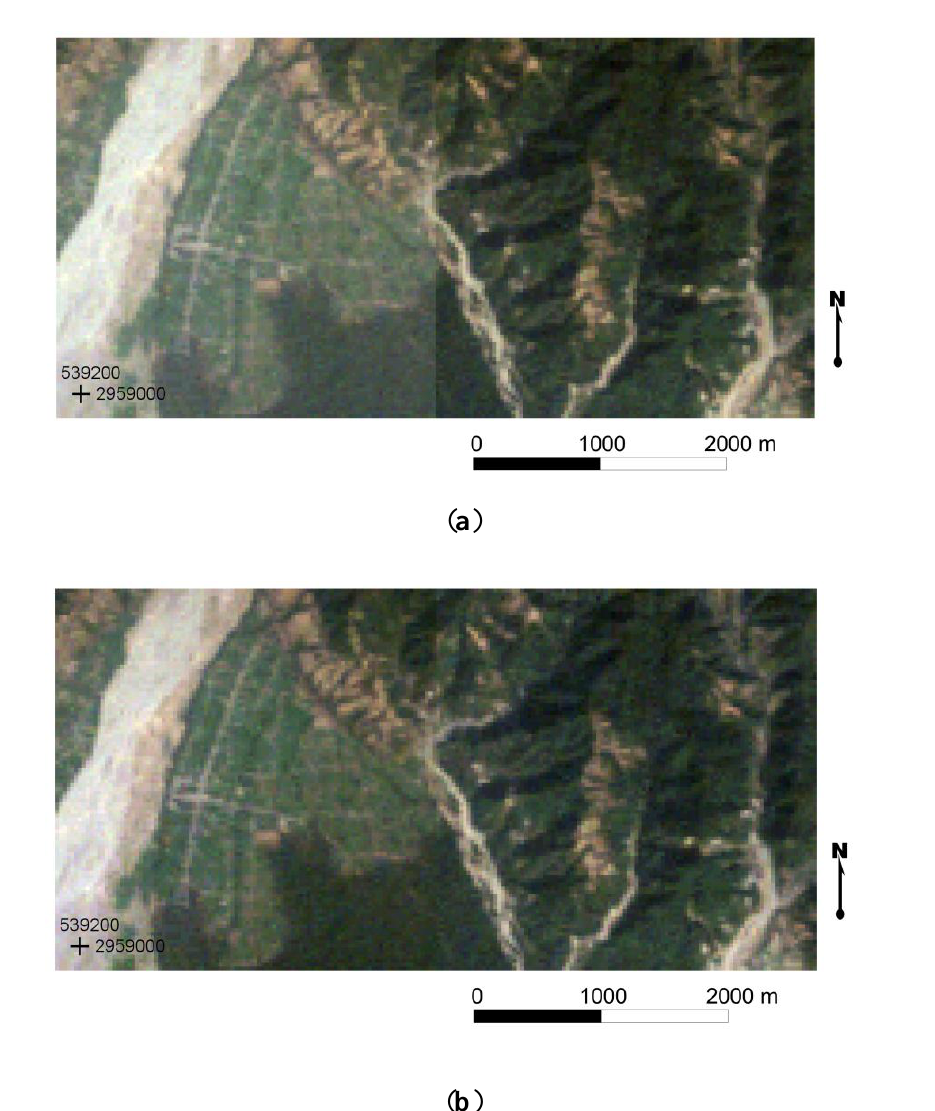
Figure 3. ( a ) Subsets of two original Landsat TM images from a region in Eastern Terai (Feb-4- 2010 for the image on the left and Jan-28- 2010 for the image on the right), a composite of TM bands 3, 2 and 1 (rgb). ( b ) A subset of the corrected Landsat TM image mosaic, a composite of TM bands 3, 2 and 1 (rgb). ( c ) A subset of the corrected Landsat TM image mosaic, a composite of TM bands 5, 3 and 2 (rgb). (Coordinate reference system: WGS 84/ UTM zone